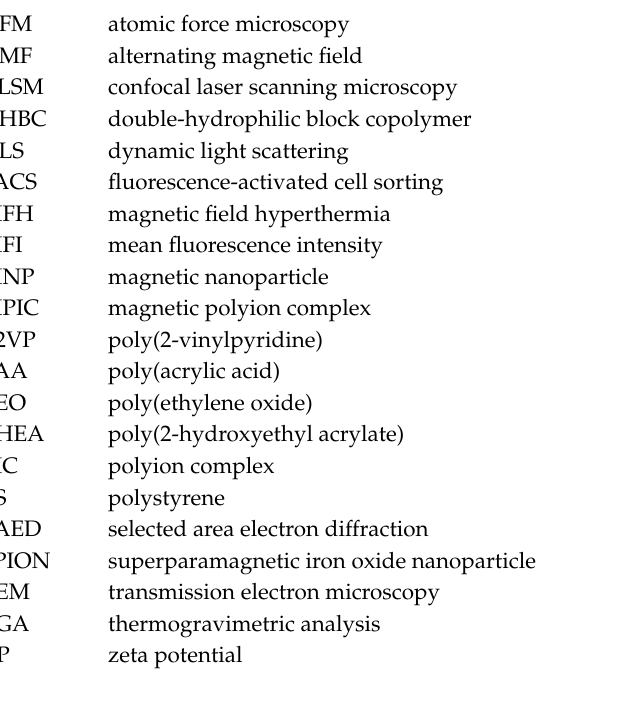
Figure S2: Photography of sample vials, Figure S3: Calibration curve for iron concentration, Figure S4: TEM images of MPIC micelles, Figure S5: AFM images of MPIC micelles, Figure S6: CLSM images of untreated L929 control cells, Figure S7: TEM images of L929 cells treated with MPIC micelles, Figure S8: Proposed mechanism for clathrin-mediated endocytosis of MPIC micelles into the L929 cells, Video S1: 3-channel confocal microscopy video showing MPIC micelles labelled with the green fluorescent probe fluoresceinamine internalized in a L929 cell of cytoskeleton F-actin labelled in red with phalloidin and the nuclei labelled in blue with